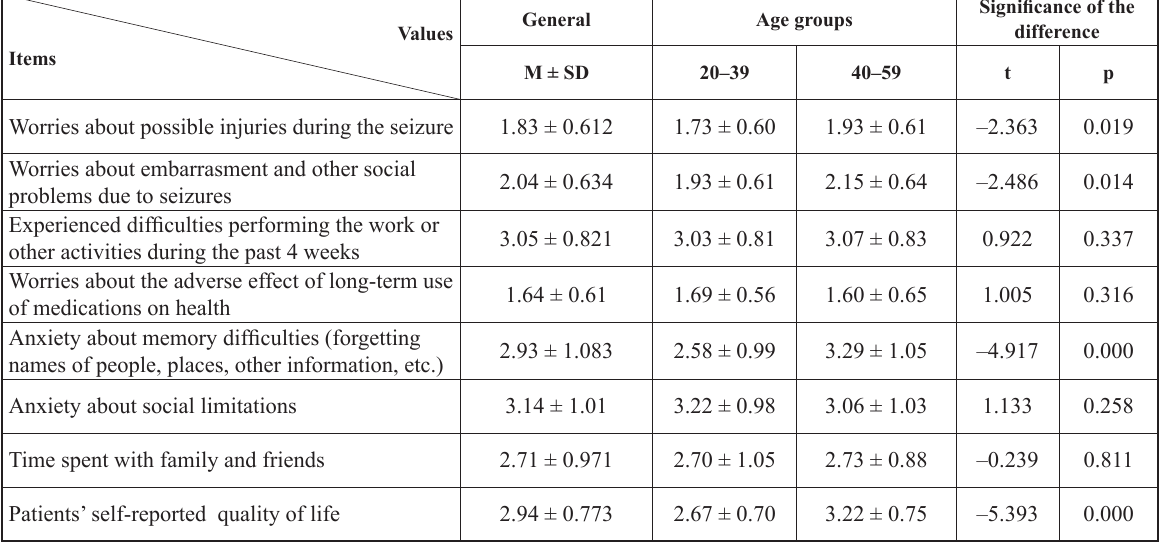
Table 1. Psychosocial problems of people with epilepsy (points)